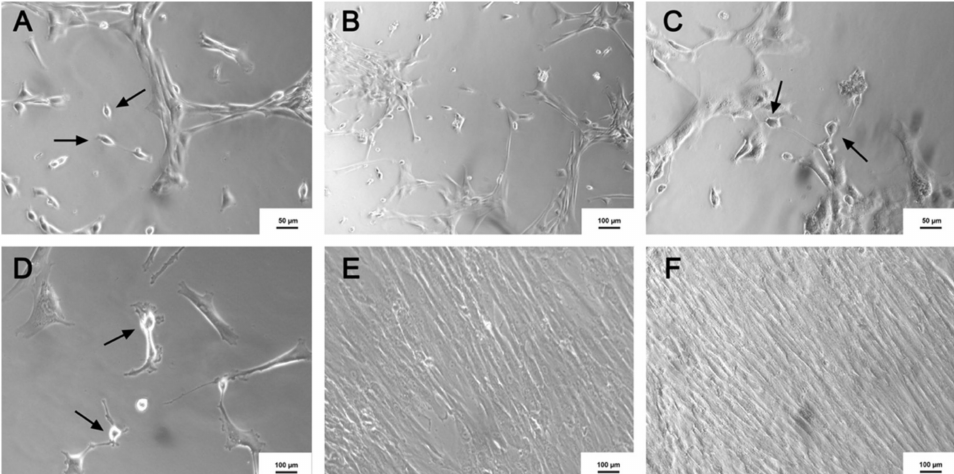
Figure 7. Cholinergic-like neurons differentiation. ( A ) 4th day after the beginning of the induction ( × 100); ( B ) 8th day after induction ( × 100); ( C ) 10th day after induction ( × 100); ( D ) 14th day after induction ( × 200); ( E ) Control (MSC) without the use of induction ( × 100); ( F ) Precursor without induction ( × 100). Black arrows represent the formation of the cholinergic-like neurons. (Image obtained using an inverted microscope x100, Axio Vert A1, Carl Zeiss, Oberkochen, Germany). Neurospheres derived from MSC-WJ, and MSC-UCB presented different